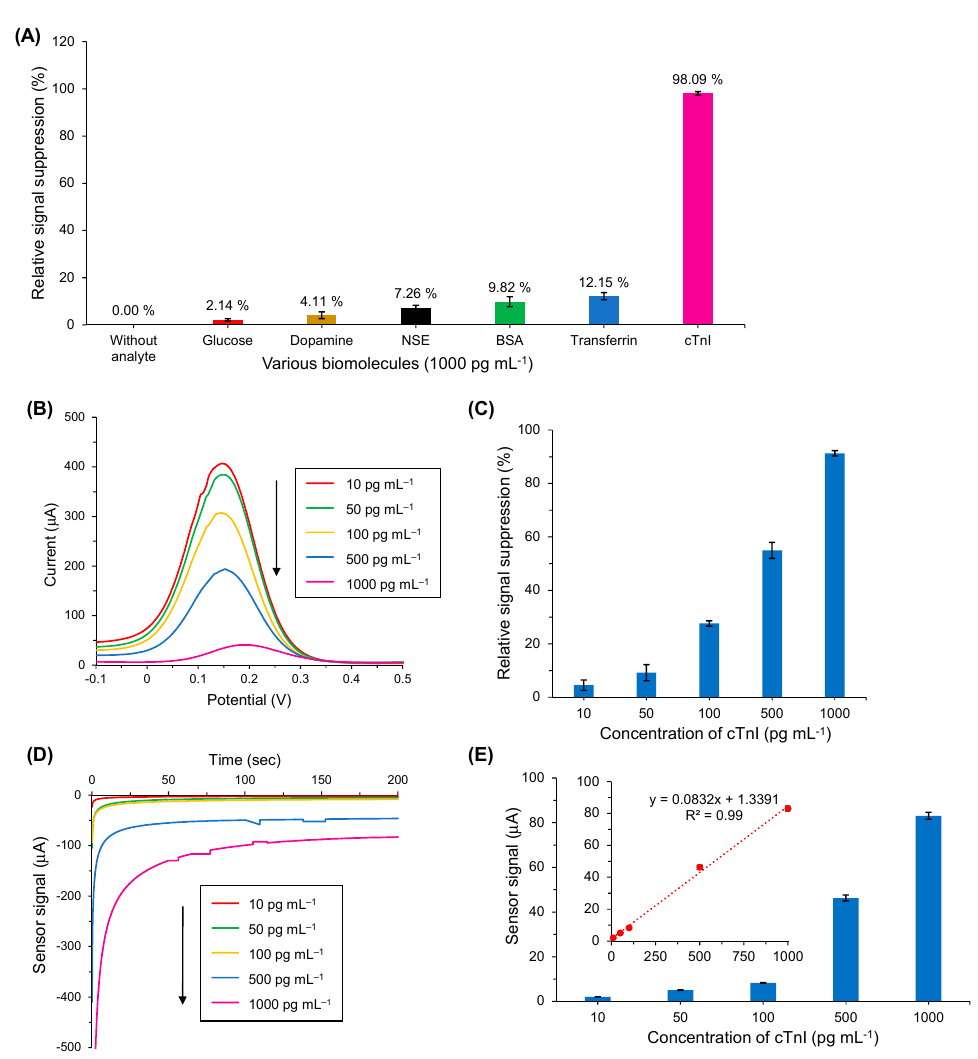
Figure 8. ( A ) Cross-reactivity tests for cTnI specific antibody sensor ( n = 3). All analytes were tested at equal concentration. ( B ) Square-wave voltammograms recorded using a redox marker containing 10 mM K 3 [Fe(CN) 6 ] and 0.1 M KCl for the target binding with anti-cTnI/AuNPs@GQDs/SPGE by preparing five different concentrations of cTnI (10–1000 pg mL − 1 ) in human serum. ( C ) Overall results of SWV-based cTnI biodetection in human serum using the antibody sensor ( n = 3). ( D ). Real-time amperometric measurements recorded using 10 mM H 2 O 2 for the target binding with anti-cTnI/AuNPs@GQDs/SPGE by preparing five different concentrations of cTnI (10–1000 pg mL − 1 ) in human serum. ( E ) Overall results of amperometry-based cTnI biodetection in human serum. The inset shows linear regression of signal–concentration relationship for 10–1000 pg mL − 1 cTnI with an R 2 value of 0.99.